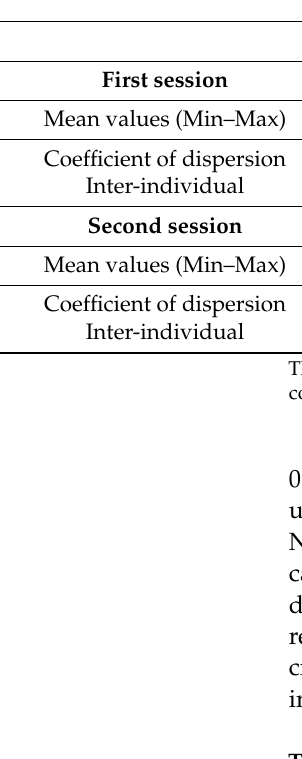
Table 5. Best normalization process for the stairs assay compliance